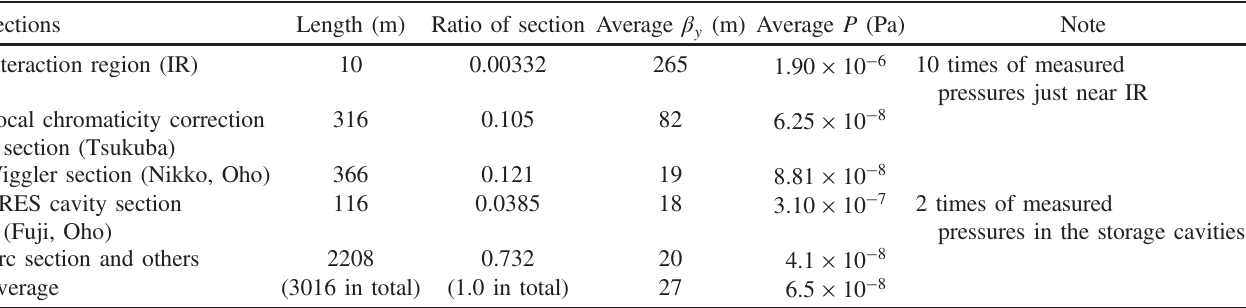
TABLE I. Sections and parameters used for the estimation of τ determined by the Rutherford scattering.